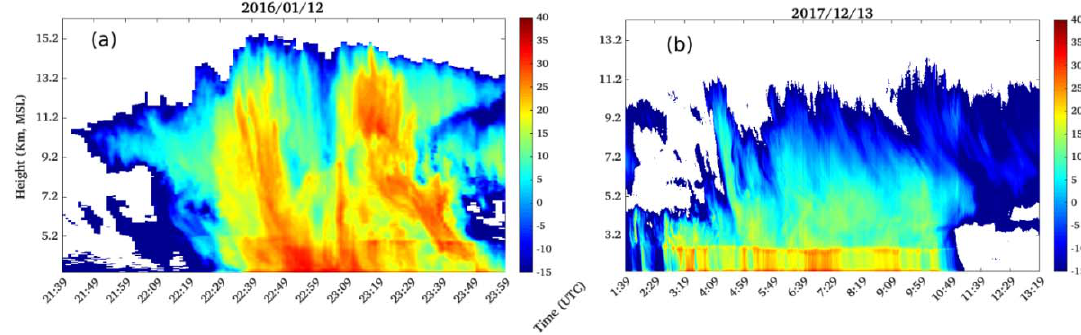
Figure 3. An example of radar reflectivity in ( a ) convective rainfall on 12 January 2016 and ( b ) stratiform rainfall on 13 February 2017.